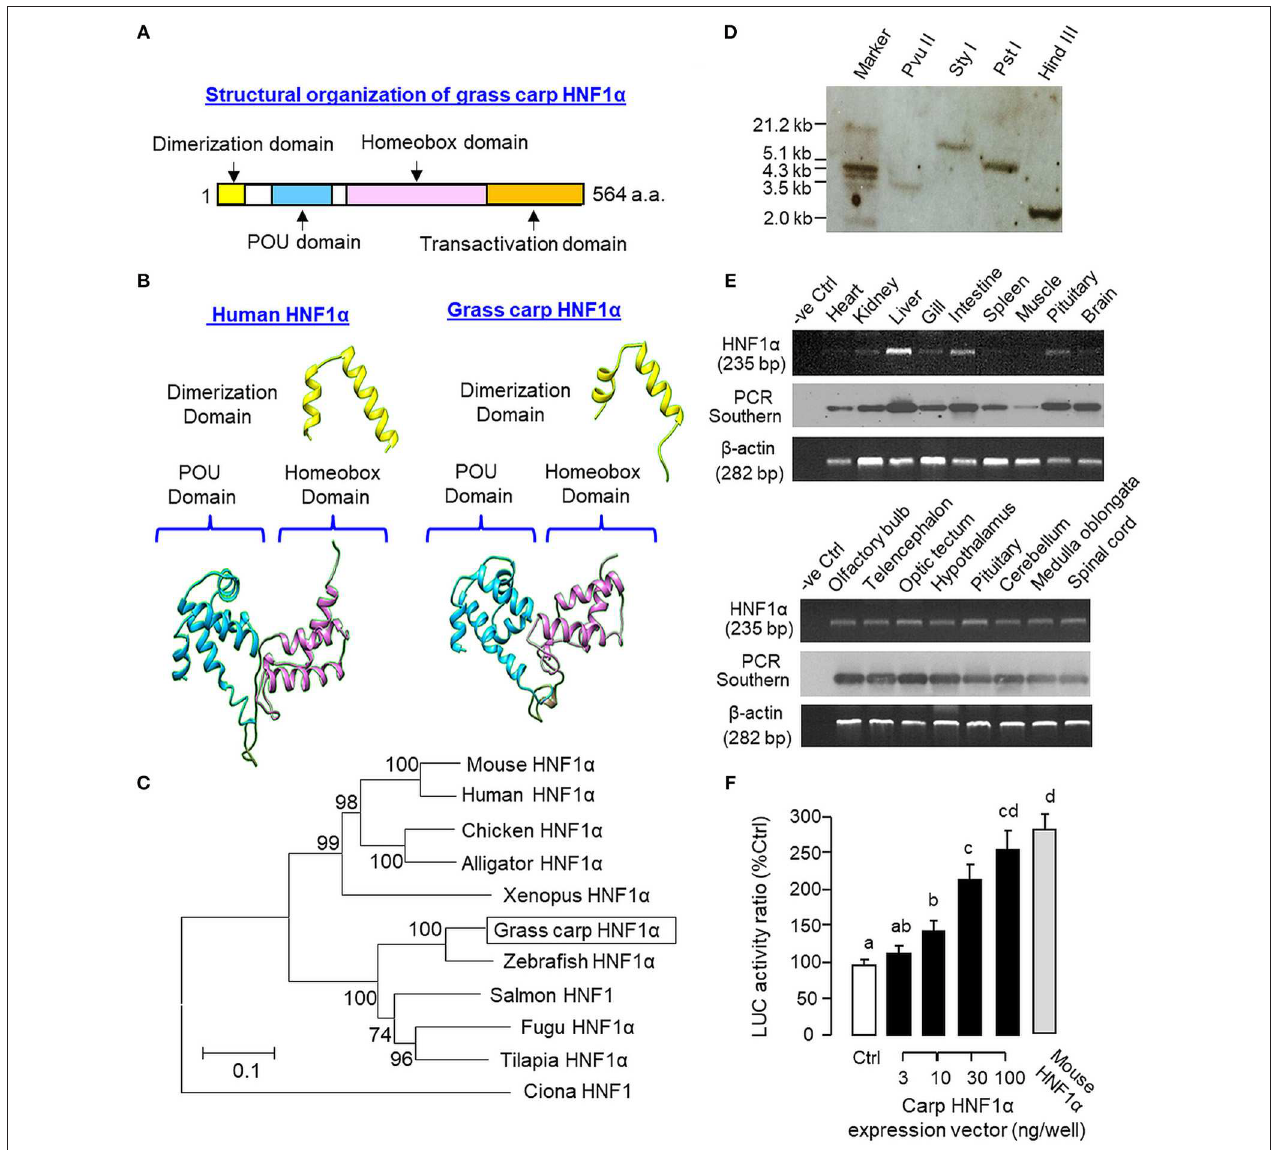
FIGURE 1 | Structural characterization, gene copy number, tissue distribution, and functional validation of grass carp HNF1 α . (A) Structural organization of carp HNF1 α a.a. sequence into four signature motifs, including the dimerization domain, POU domain, homeobox domain, and transactivation domain. (B) 3D Protein modeling of the dimerization domain, POU domain, and homeobox domain of carp HNF1 α using the corresponding structures of their human counterparts as the template with SWISS-MODEL program. (C) Phylogenetic analysis of carp HNF1 α cDNA sequence using the neighbor-joining method with MEGA 6.0 with the corresponding sequences identified in other species. The scale bar represents the evolutionary distance and the values for individual nodes of the guide tree are the percentage based on 1,000 bootstraps. (D) Copy number of HNF1 α gene in the carp genome. Southern blot was conducted in genomic DNA after digestion with Pvu II, Sty I, Pst I, and Hind III, respectively, using a DIG-labeled cDNA probe for HNF1 α . (E) Tissue expression profiling of HNF1 α with RT-PCR. Total RNA was isolated from selected tissues and brain areas and subjected to RT-PCR using primers specific for carp HNF1 α . The authenticity of PCR products was confirmed by PCR Southern and RT-PCR for β actin was used as the internal control. (F) Functional expression of carp HNF1 α in α T3 cells. The ORF of grass carp HNF1 α was subcloned into the eukaryotic expression vector pcDNA3.1 and transfected into α T3 cells with the Luc reporter pGL 3 .HNF1 α .Luc with tandem repeats of HBE sites in its 5 ′ promoter. In this study, parallel transfection with the expression vector for mouse HNF1 α was used as a positive control. Data presented are expressed as mean ± SEM and groups denoted by different letters represent a significant difference at p < 0.05 (ANOVA followed by Newman-Keuls